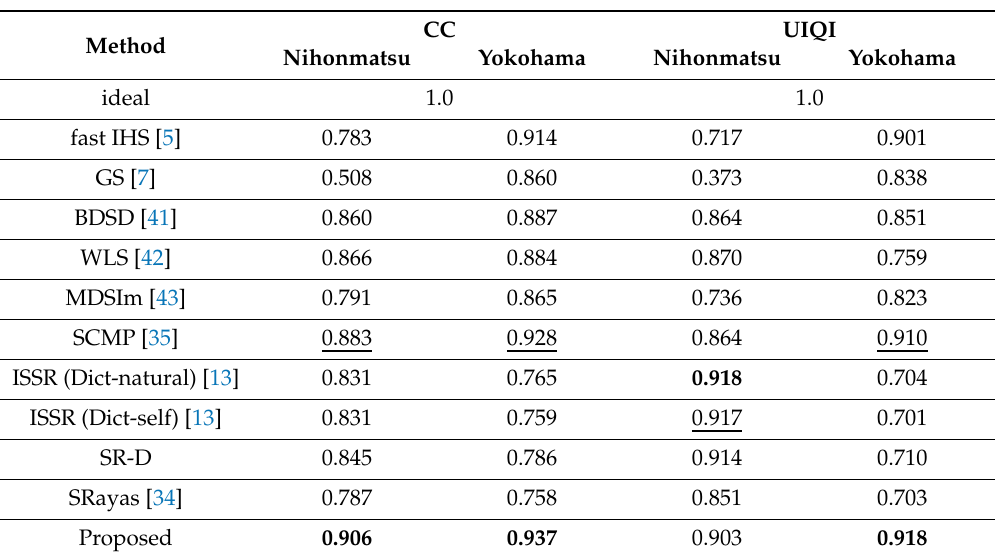
Table 7. Numerical evaluation of the existing methods and the proposed method by CC and UIQI. The highest scores are printed in bold, and the second highest scores are